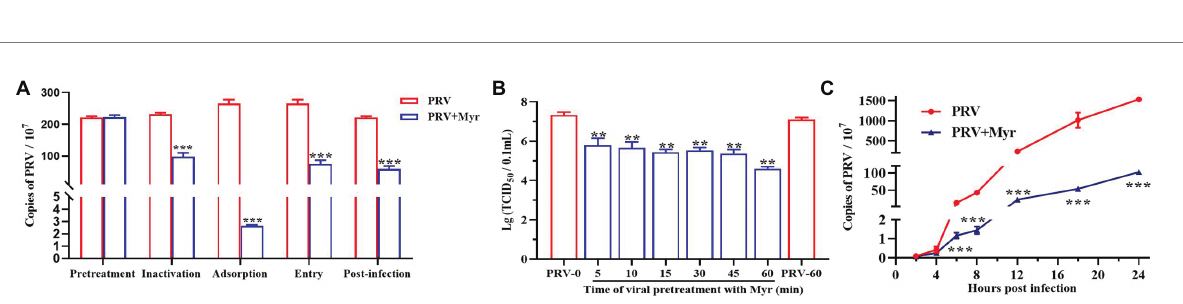
FIGURE 3 The antiviral mechanism of Myricetin. (A) Mode of action study. Myricetin was added on PK-15 cells for 1 h, and after washing, the cells were infected with PRV (Pretreatment). Myricetin was incubated with PRV for 1 h, and then added into cells after dilution (Inactivation). Myricetin was mixed with PRV to infect cells and replaced by new culture medium after adsorbed 1 h at 4 ° C (Adsorption). Myricetin was added to cells after PRV adsorption for 1 h at 4 ° C, and then cells were incubated for 1 h at 37 ° C followed by wahsing with citric acid-sodium citrate buffer (Entry). Myricetin was added after cells was infected with PRV for 1 h at 37 ° C (Post-infection). (B) Time course of virucidal activity. PRV and myricetin were incubated for different time periods and then serially diluted on PK-15 cells for determining viral titers (TCID 50 ). (C) Growth curve. After infection for 1 h, PK-15 cells were treated with myricetin and the viral gene copies at different time were detected. PRV, the infected group without treatment; PRV + Myr, the infected group with myricetin treatment (0.5 mM). Values are presented as means ± SD ( n = 6). Symbols “** and ***” represent p < 0.01 and p < 0.001, respectively, between the PRV group and PRV + Myr